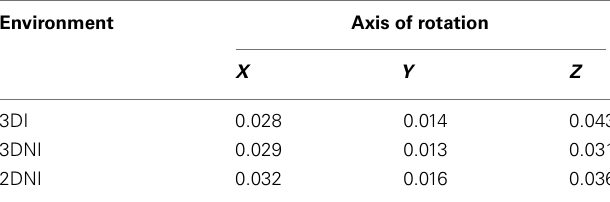
Table 2 | Mean regression slopes of RT-Rotation angle function